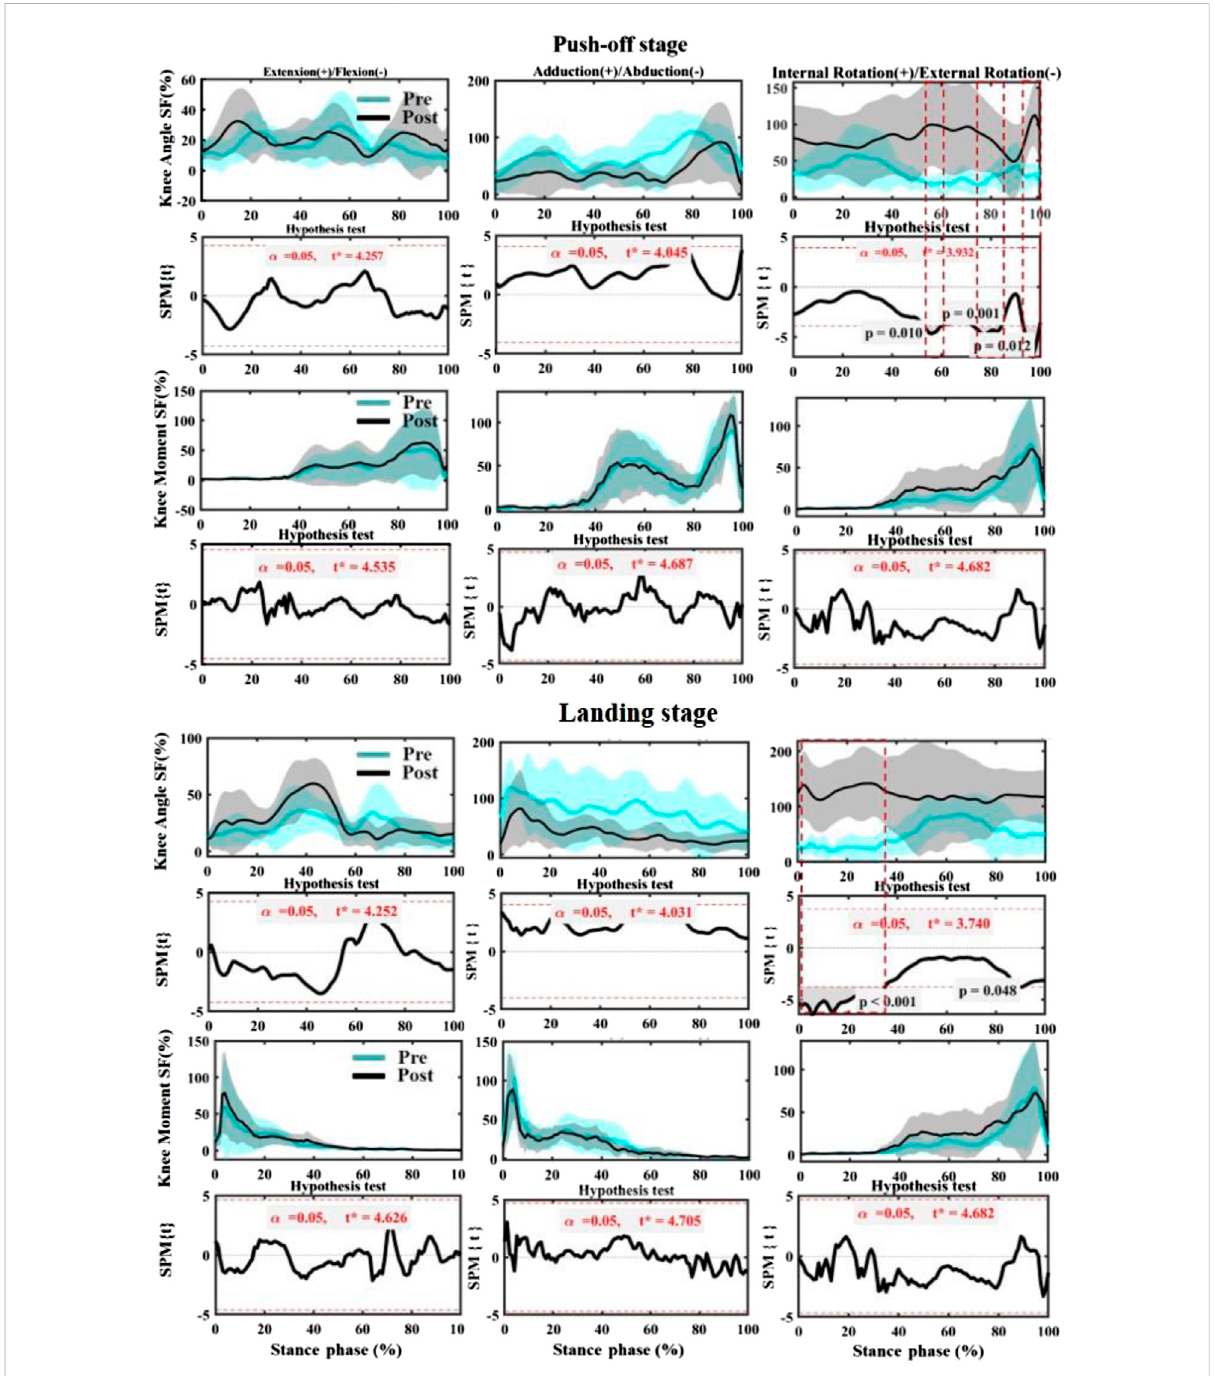
FIGURE 6 ComparingthemeanvaluesofSFofkneeangleandmomentfromallparticipantsbetweenfatigues(pre-fatigue;postfatigue).Note:thedotted boxes indicate a statistically signi fi cant difference, p < 0.05. Pre means Pre-fatigue, and Post means